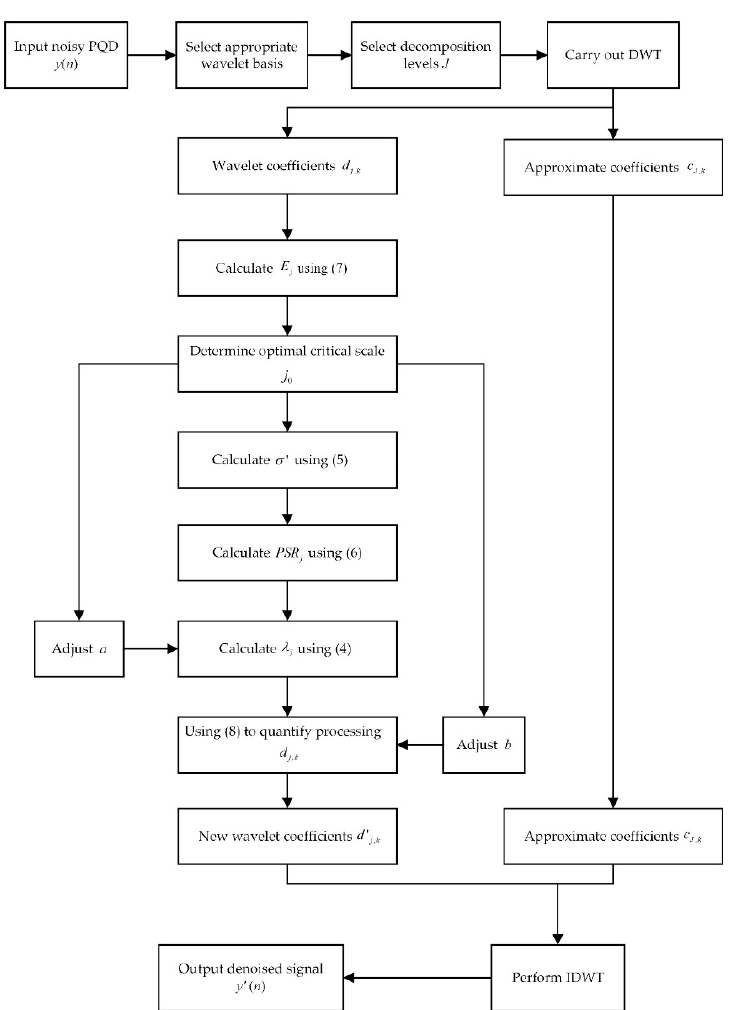
Figure 2. The proposed algorithm for denoising PQ disturbances is depicted schematically in the flowchart.